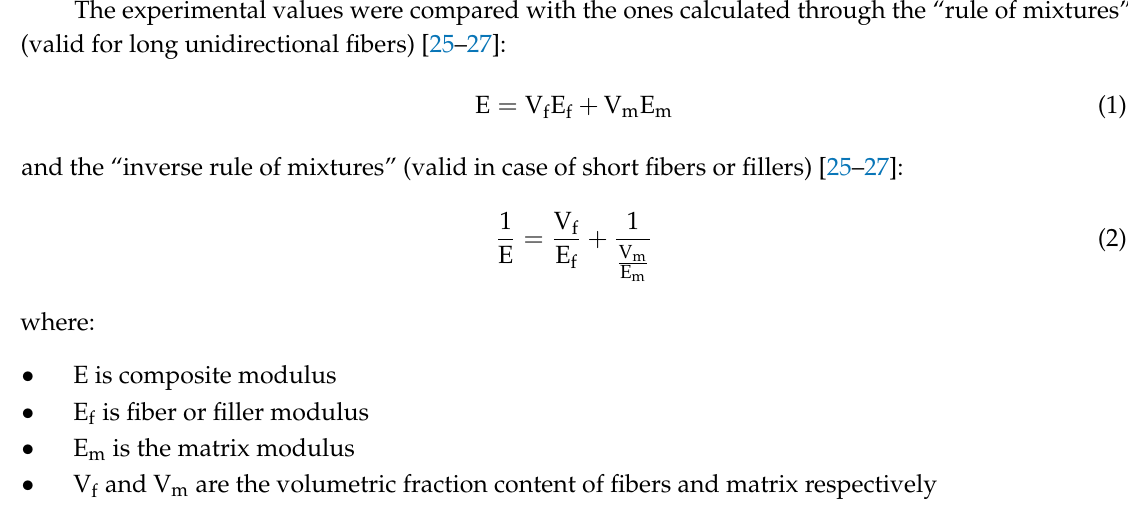
Figure 9. The di ff erence between the experimental and theoretical values of moduli for di ff erent Figure 9. The difference between the experimental and theoretical values of moduli for different volumetric percentages of filler content in the epoxy volumetric percentages of filler content in the epoxy resin.